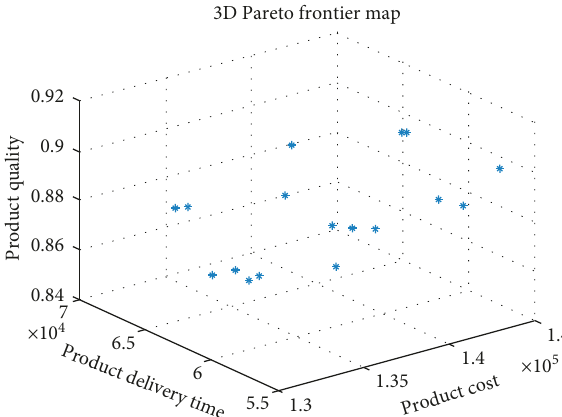
Figure 5: Solution set of Pareto.